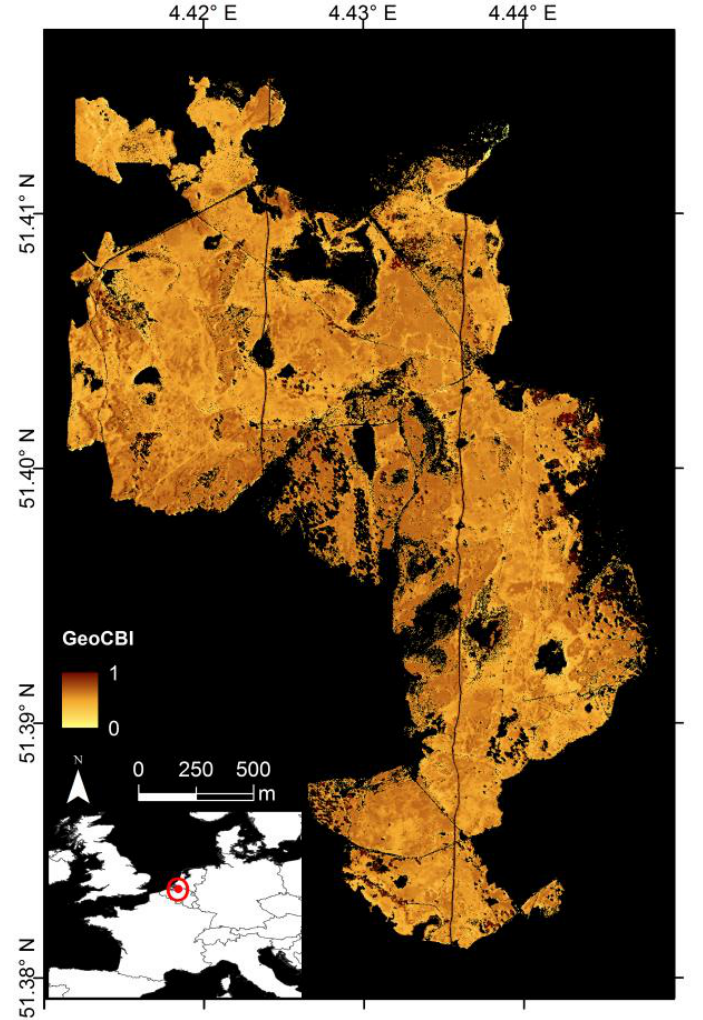
Figure 5. Burn severity spatial distribution of the 2011 fire at the Kalmthoutse Heide , produced by using the optimal regression parameters per vegetation type (see Table 7). The burn severity is expressed in